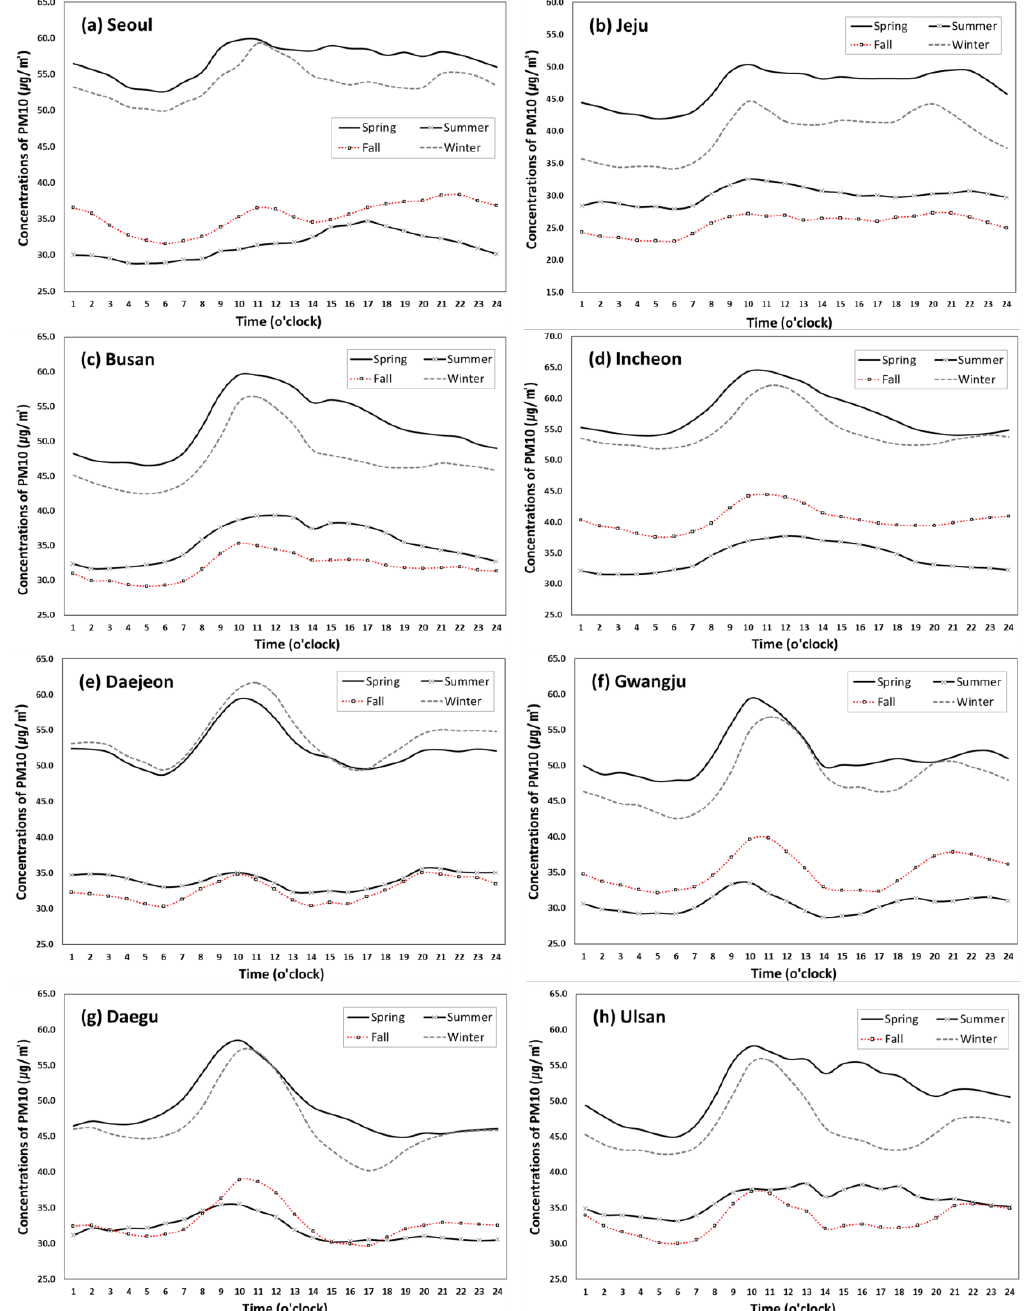
Figure 4. Diurnal variation of PM10 concentrations (µg/m 3 ) by season in each region (2015–2019).